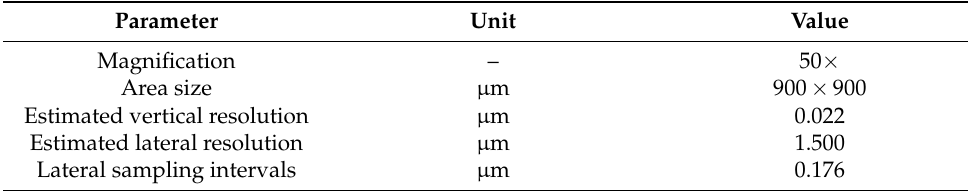
Table 3. Surface measurement